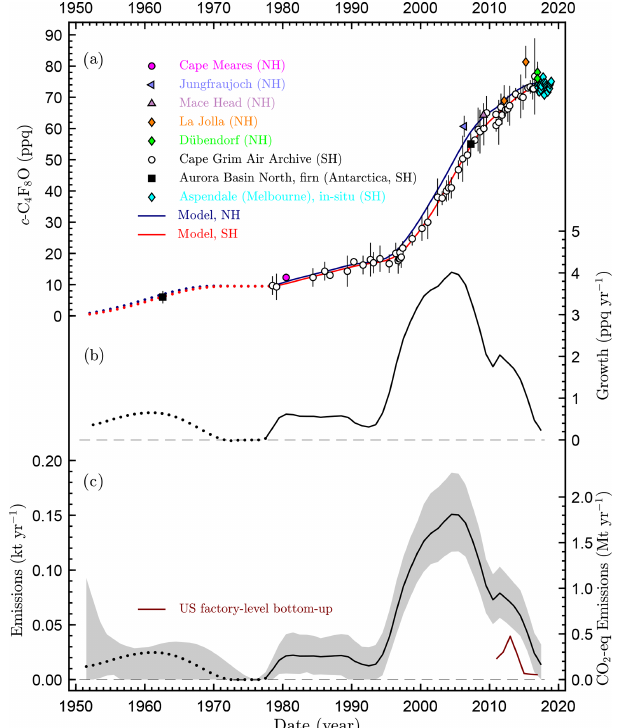
Figure 2. Atmospheric observations (a) , growth rates (b) , and emissions (c) of octafluorooxolane (octafluorotetrahydrofuran, c - C 4 F 8 O). Abundances are given as dry air mole fractions in ppq (femtomolmol − 1 ) on the Empa-2013 primary calibration scale. Vertical bars denote the measurement precision (2 σ ) for the flask samples. Emission uncertainties are 2 σ . Samples were collected in the Northern Hemisphere at Cape Meares (Oregon; 45.5 ◦ N, 124.0 ◦ W), Jungfraujoch (Switzerland; 46.5 ◦ N, 8.0 ◦ E), Mace Head (Ireland; 53.3 ◦ N, 9.9 ◦ W), La Jolla (California; 32.9 ◦ N, 117.3 ◦ W), and Dübendorf (Switzerland; 47.4 ◦ N, 8.6 ◦ E). Southern Hemisphere samples were mainly from the Cape Grim Air Archive collected at Cape Grim (Tasmania; 40.7 ◦ S, 144.7 ◦ E), two sam- ples from the Aurora Basin North firn air sampling site (Antarc- tica, 71.2 ◦ S, 111.4 ◦ E), and in situ monthly means since Febru- ary 2017 from Aspendale, Victoria, Australia (38.0 ◦ S, 145.1 ◦ E), with uncertainty bars for Aspendale omitted to aid visual clarity. Growth rates and emissions are globally averaged. Emissions (c) are shown with units on the left y axis and as CO 2 -equivalent emis- sions based on a global warming potential of 12000 (100-year time frame), with units on the right y axis. USA factory-level emissions are from https://www.epa.gov/ghgreporting, last access: 30 January 2019. The early history is shown as dotted lines to emphasize the greater uncertainties before 1978.